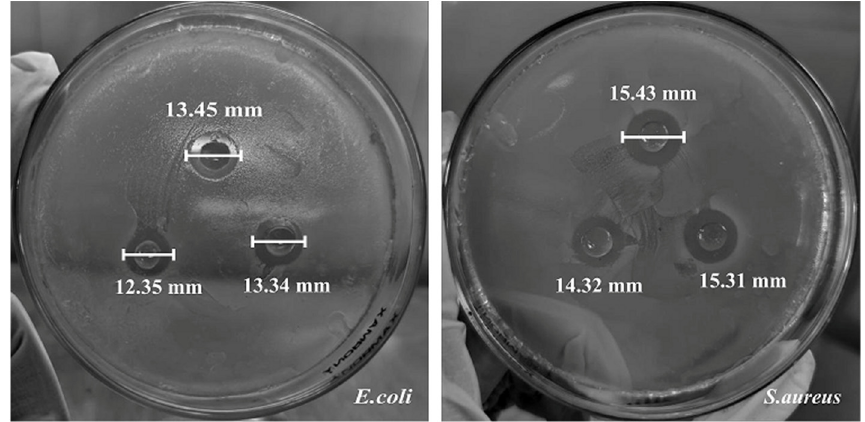
Figure 6. Effect of CMBC/Nano-Ag/NBC composite film against S. aureus and E. coli . Table 2. TGA thermal values and inhibition diameter of composite film made from bacterial- or plant-derived celluloses *.